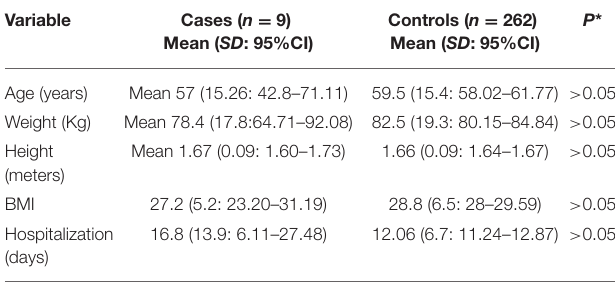
TABLE 3 | Features from COVID-19 patients who developed spontaneous pneumomediastinum.